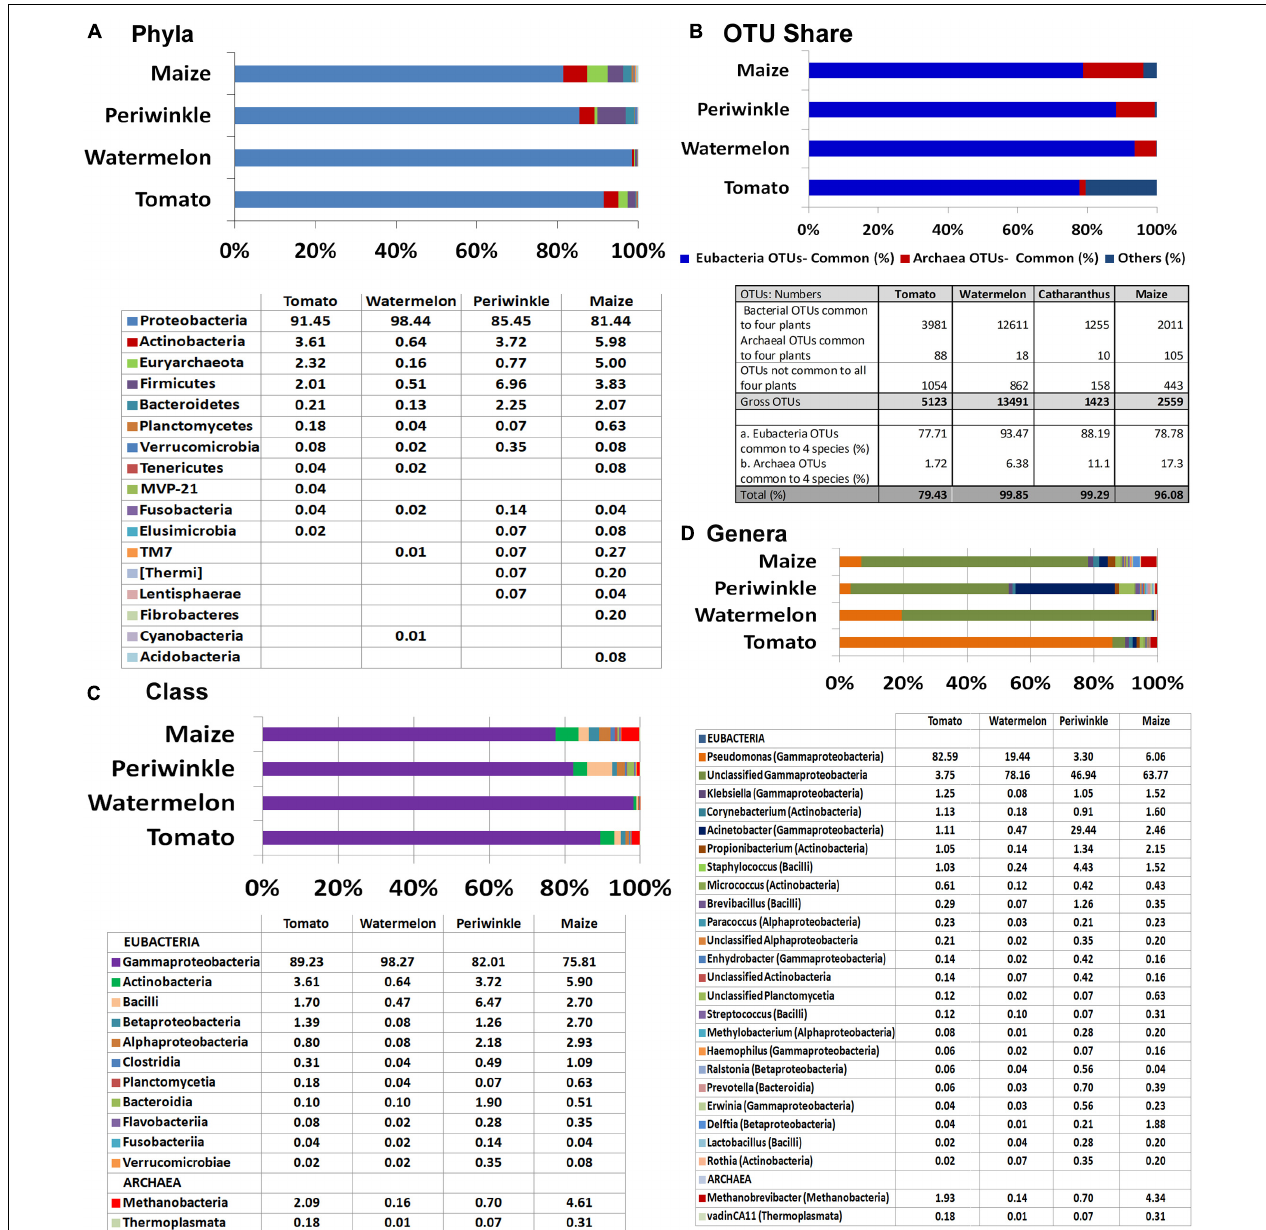
FIGURE 2 | Illumina MiSeq NGS-based bacterial diversity analysis on surface-sterilized shoot-tip tissues of four plant species. 16S rRNA gene V3–V4 region profiling of tomato, watermelon, periwinkle, and maize showing (A) distribution of OTUs under different phyla. (B) OTU shares common to different plant species. (C) Major classes and (D) major